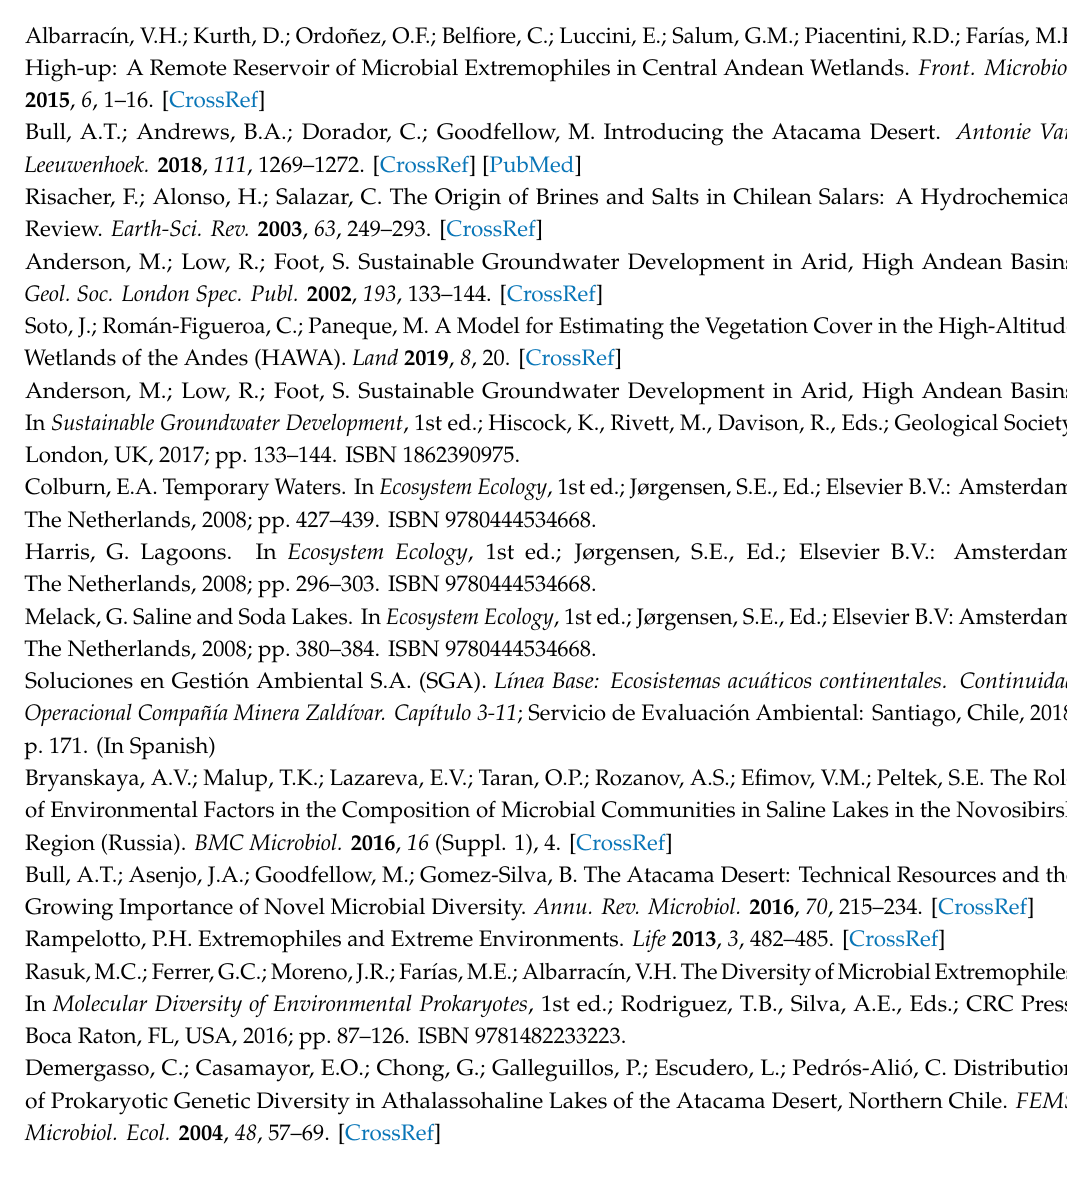
Figure S1: The α -diversity of microorganisms present in the water columns of the La Brava and La Punta lake system, Figure S2: Cluster analysis of the di ff erent sampling points of the La Brava–La Punta lake system using the Ward method, based on dissimilarities of β -diversity, Table S1: Comparison between lakes and physicochemical parameters of the water column samples obtained from the La Brava–La Punta lake system during the summer Table S3: Influence of environmental physicochemical parameters on the α -diversity of the La Brava-La Punta lake, Table S4: Relative abundance of the first 31 genera in the La Brava and La Punta lake system, Data S1: Genera in La Brava and La Punta lakes at Salar de Atacama,